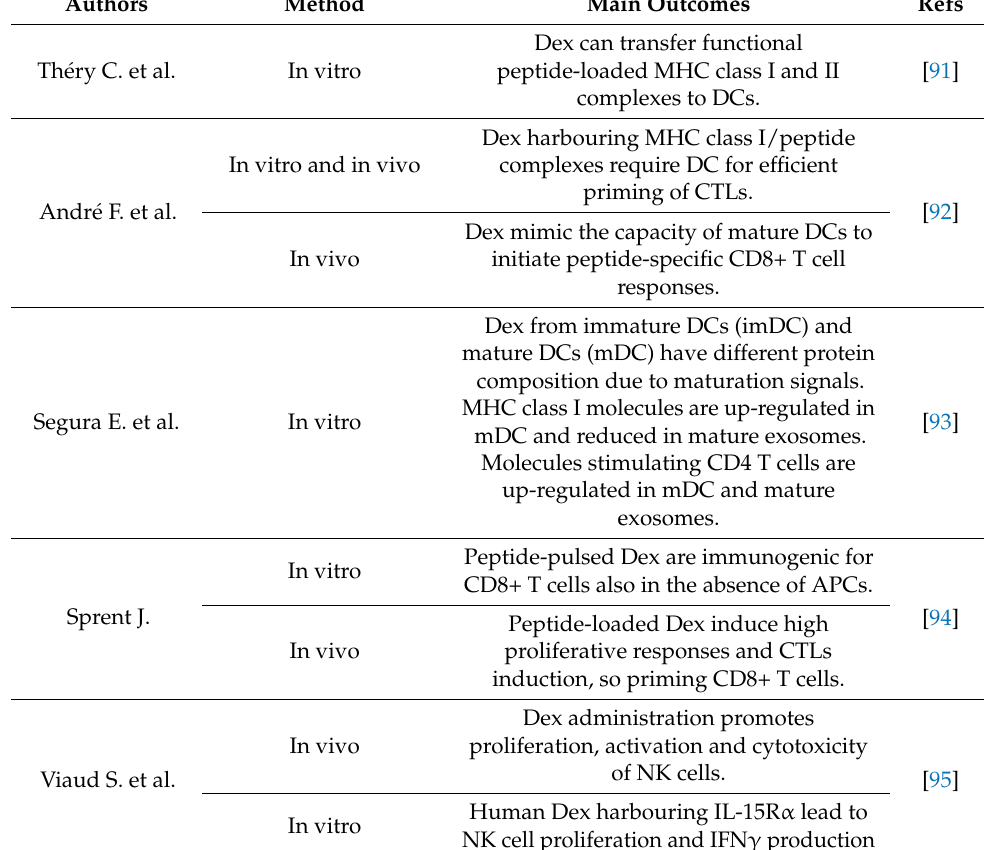
Table 2. Preclinical studies evaluating Dex immunogenicity for cancer